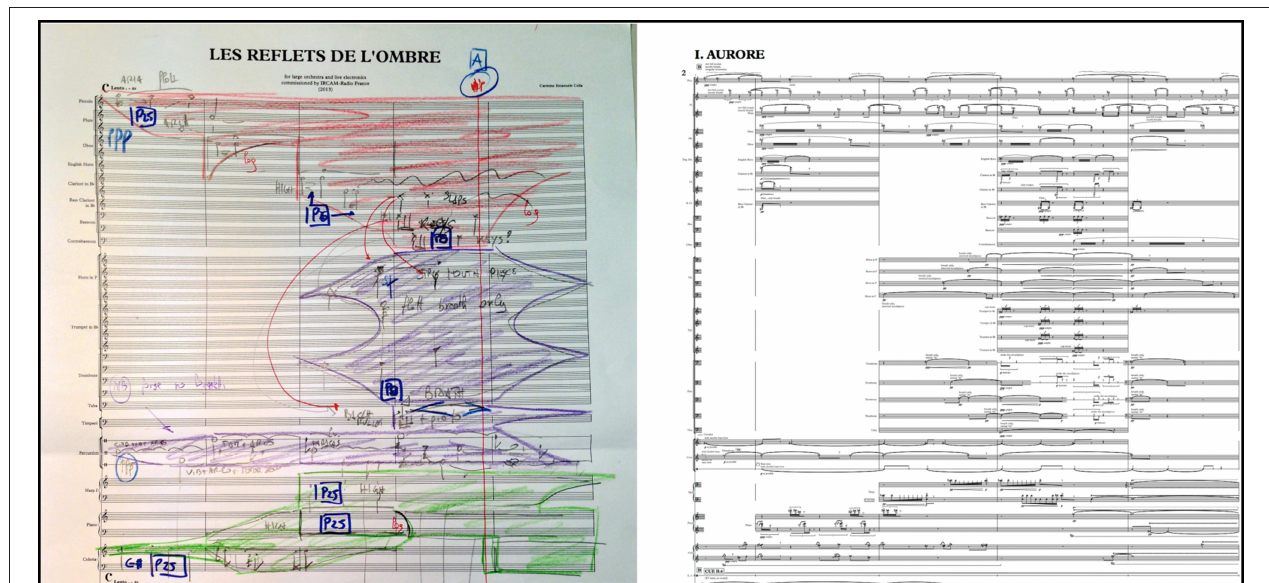
FIGURE 9 | The figure shows a high-level compositional representation used by the author in his piece Reflets de l’ombre (2013) for large orchestra and electronics. In the left part of the image, there is a drawing aimed at outlining the spectral morphology of the piece, together with high-level specific information such as musical figures and harmonies. It sketches a high-level visualization of an imaginary musical situation before the actual realization by means of notes, durations and so on. From a composer’s perspective, such image is a static mono-dimensional entity that is related to other musical ideas during the development of the piece: for example, this drawing represents a sound that the composer defines hollow . In the right part, there is the corresponding actual orchestral score: the actual realization of the musical idea lies in a high-dimensional space given by the multiple entities involved: notes, durations, playing styles and so on. Each entity has a large space of variations that interacts with other entities: each time-point of the piece can be used for any combination of notes with any duration thus having a large space of possibilities. It is very difficult (if possible) to find a formal relation between the two representations. Even if these mental representations probably cannot be fully captured and described even by StarAI methods, we believe that these methods can be used to approach better such kind of representations: a logic-based language in connection with sound-related description helps in defining the connection between musical ideas and their